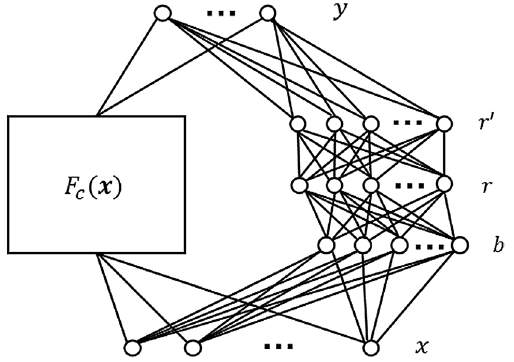
Figure 1. Architecture of a KBaNN for bi-fidelity modelling. A correction is made to the outputs ( y ) of a coarse, low-fidelity model F c ( x ) by a network consisting of boundary neurons ( b ), region neurons ( r ), and ′ normalised region neurons ( r ) for an input x